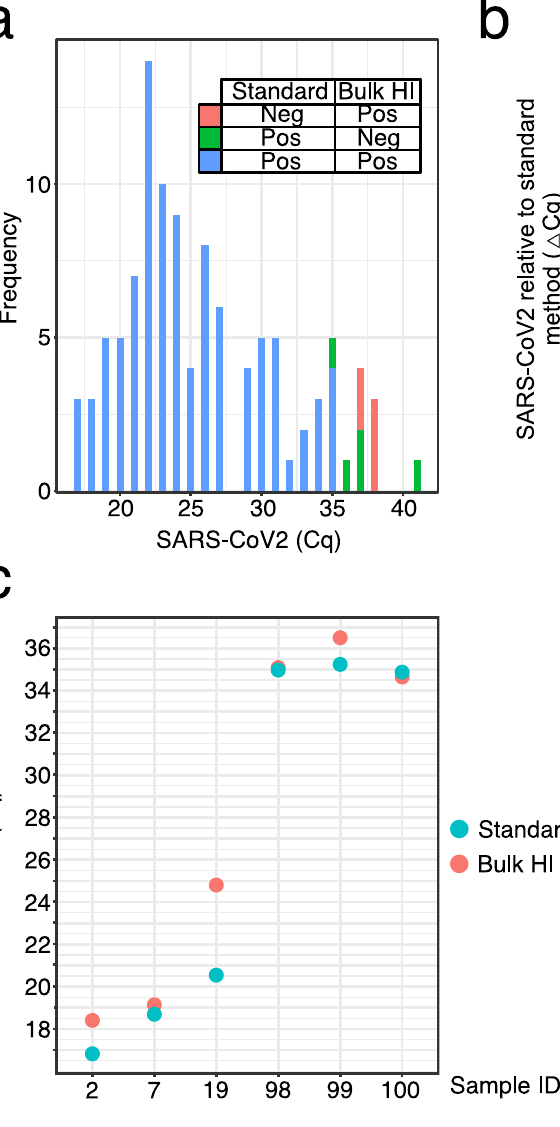
Figure 3. Bulk HI concordance data using clinical OP/NP samples. ( a ) Concordance of SARS-CoV-2 RT-qPCR test results for clinical OP/NP samples which tested positive in either the standard clinical assay or using the bulk HI protocol, and binned according to the clinical assay Cq. ( b ) Distribution of change in Cq value (Clinical Cq—Experimental Cq) versus the clinical test for the primary bulk HI protocol (bulk HI) and variations (deliberate delay of 10 or 24 h post HI, or the fall-back method of a second HI step in the lab (2HI). ( c ) Selected samples from ( a ) showing the impact of bulk HI on RT-qPCR detection is not Cq dependent. Data was plotted using R (v4.1.0 “Camp Pontanezen”) with ggplot2 (v3.3.3) and the figure was assembled using Affinity Designer